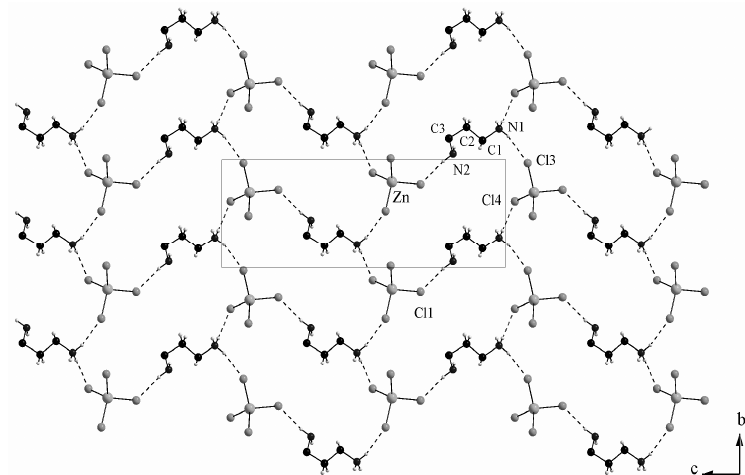
Figure 3. Hydrogen bonding which form representation of ( (( ( ) )) ) 26R 6 bonded ring type in [C